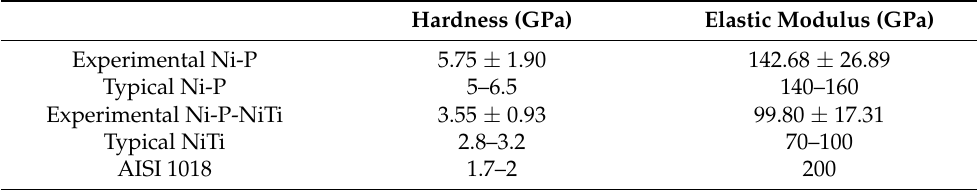
Table 6. Experimental Data Compared to Typical Values.